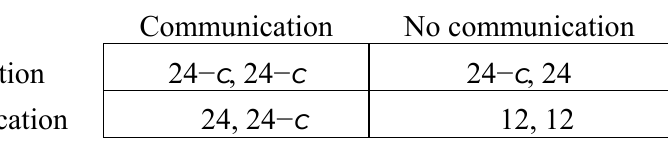
Figure 2. Reduced communication